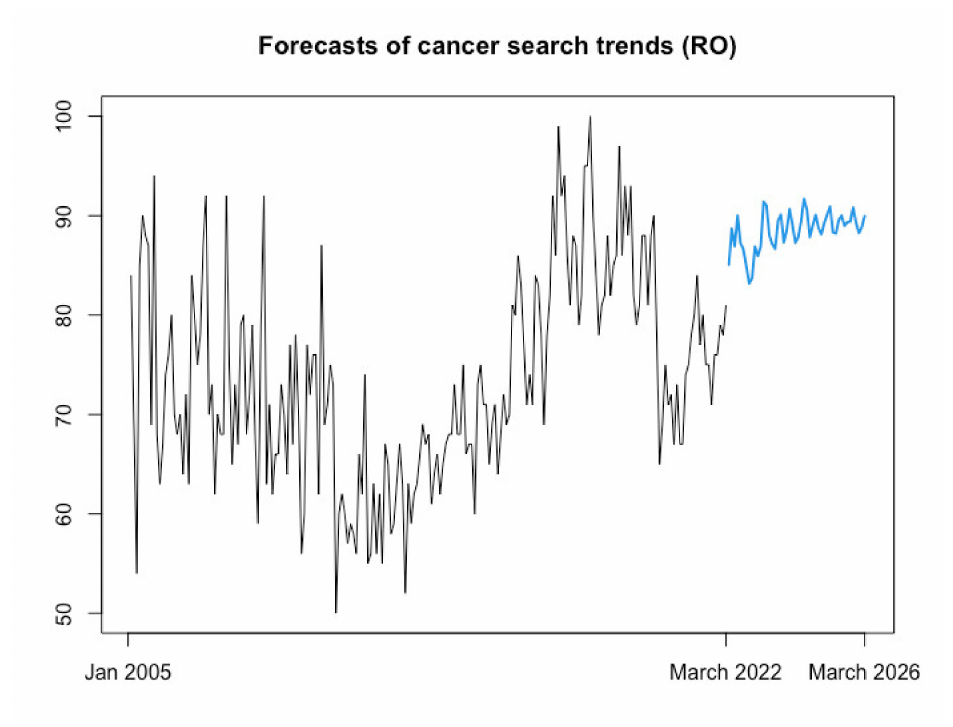
Figure 7. Forecasted trend over April 2022–March 2026 (48 months) for web queries for the term “cancer” in Romania issued with NNAR (12,6). Source: estimation results. Model information: average of 20 networks, each of which is a 12-6-1 network with 85 weight options.